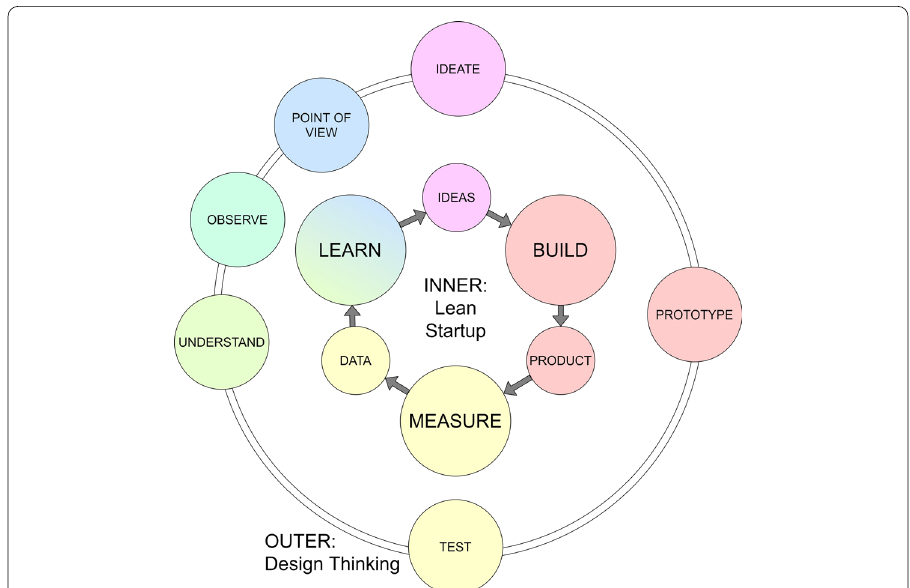
Fig. 3 Comparison between LS BML and DT process model (adapted from Hasso et al., 2009, p. 220;